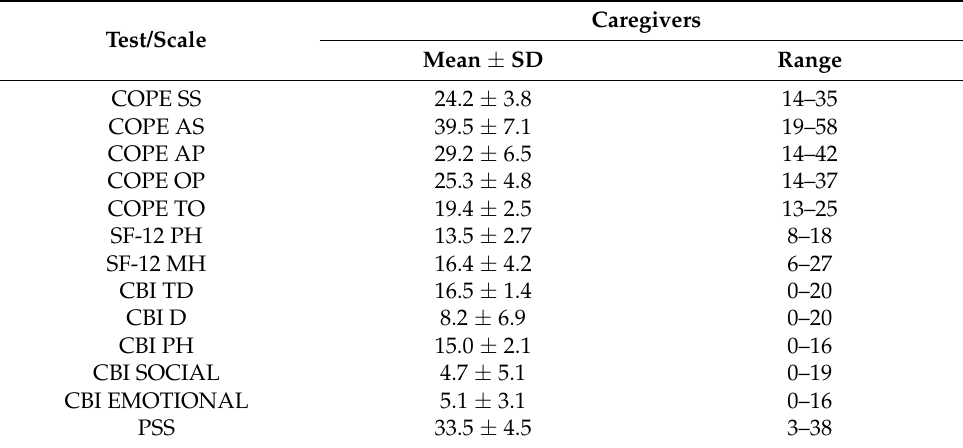
Table 3. Average of the clinical scale of caregivers.